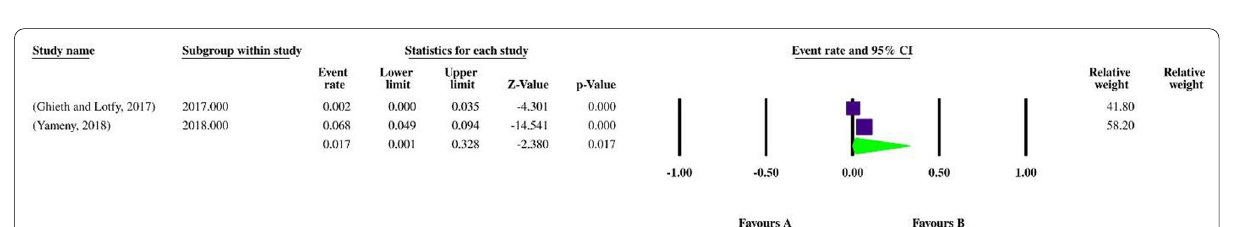
Fig. 8 Forest plot of year-based prevalence in Egypt